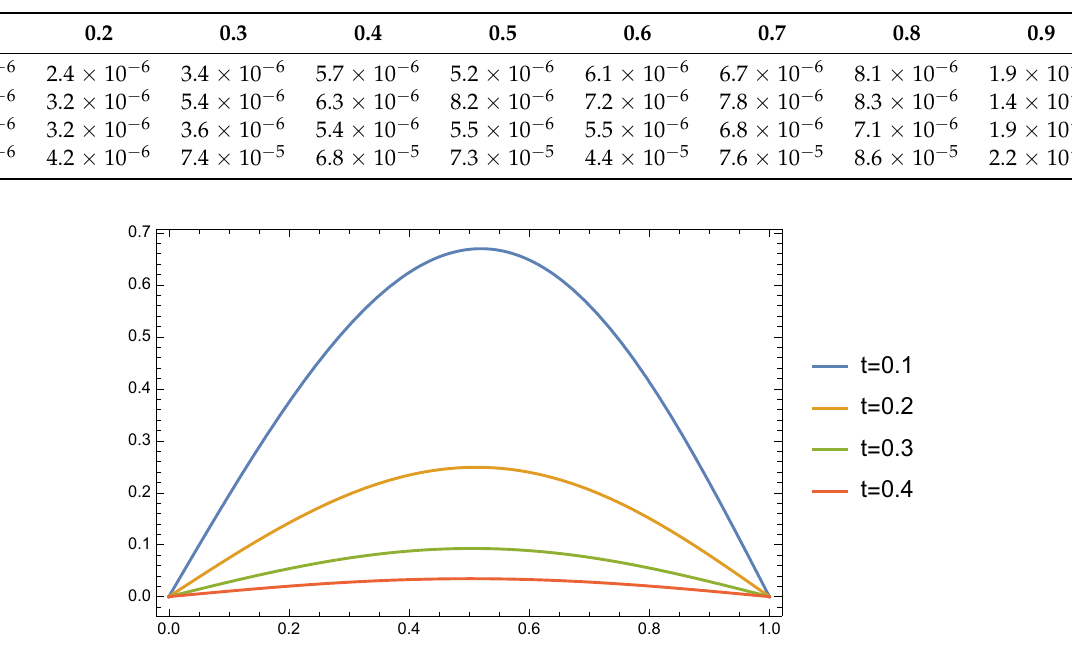
Table 2. Errors of Example 2, when ν = 1 and N = 6.